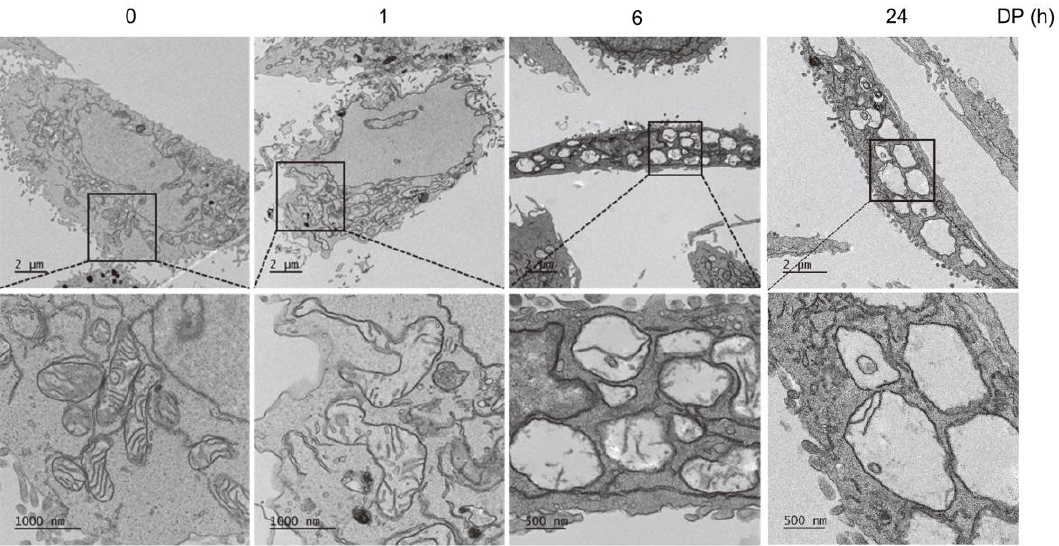
Figure 2. DP-induced mitochondrial expansion. After treatment with 40 µ M DP for 1, 6, and 24 h, the A549 cells were observed using transmission electron microscopy.